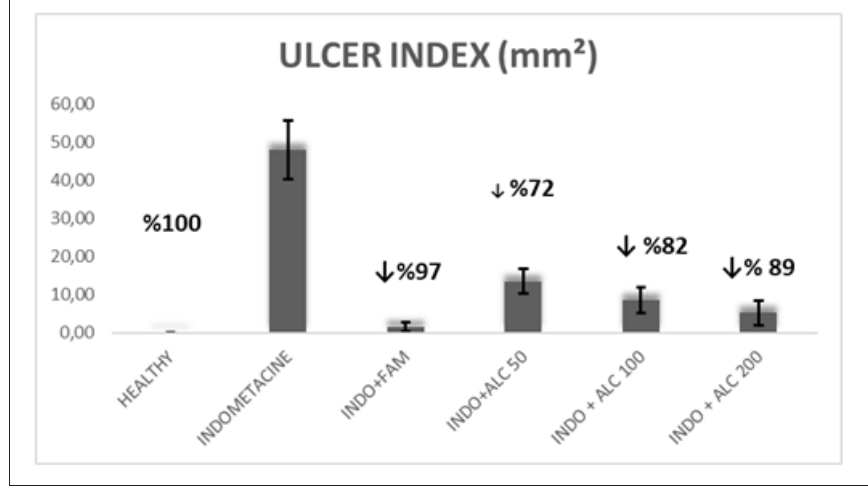
Figure 1. A Ulcer index of all groups Table 1. Histopathological ulcerated area scoring results Lymphatic cell increase